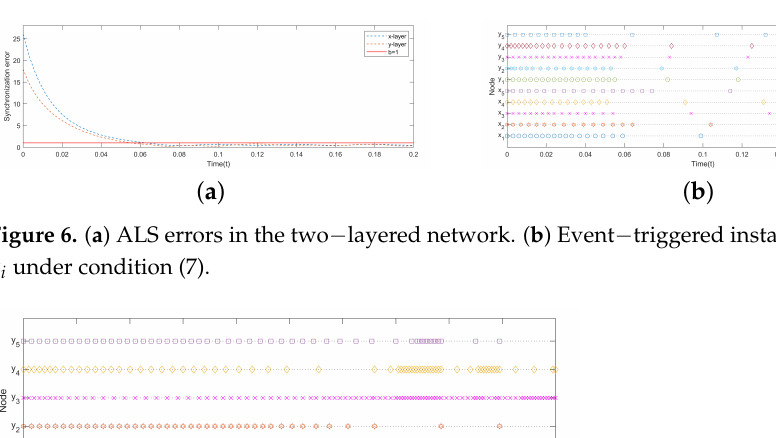
Figure 5. Event − triggered instants on nodes x i and y i under condition (3).